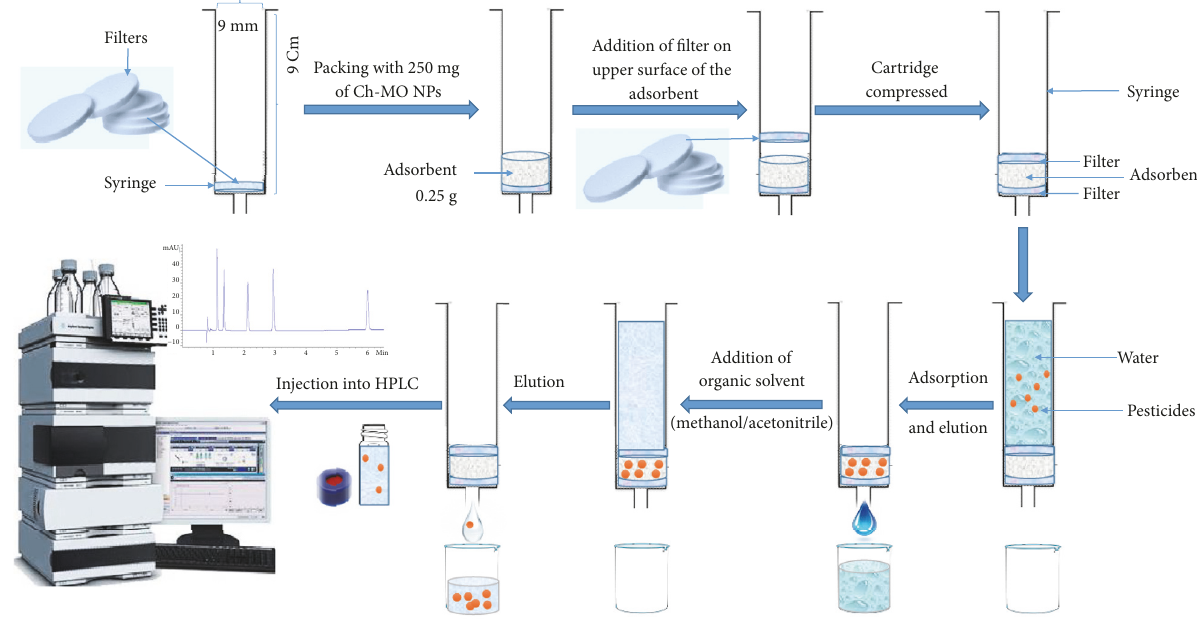
Figure 1: A schematicdiagram shows extraction and clean-up of pesticides using SPE cartridge packed with Ch-MO NPs (Ch-CuO NPs and Ch-ZnO NPs). This figure is reproduced from Badawy et al. (2018) (under the Creative Commons Attribution License/public